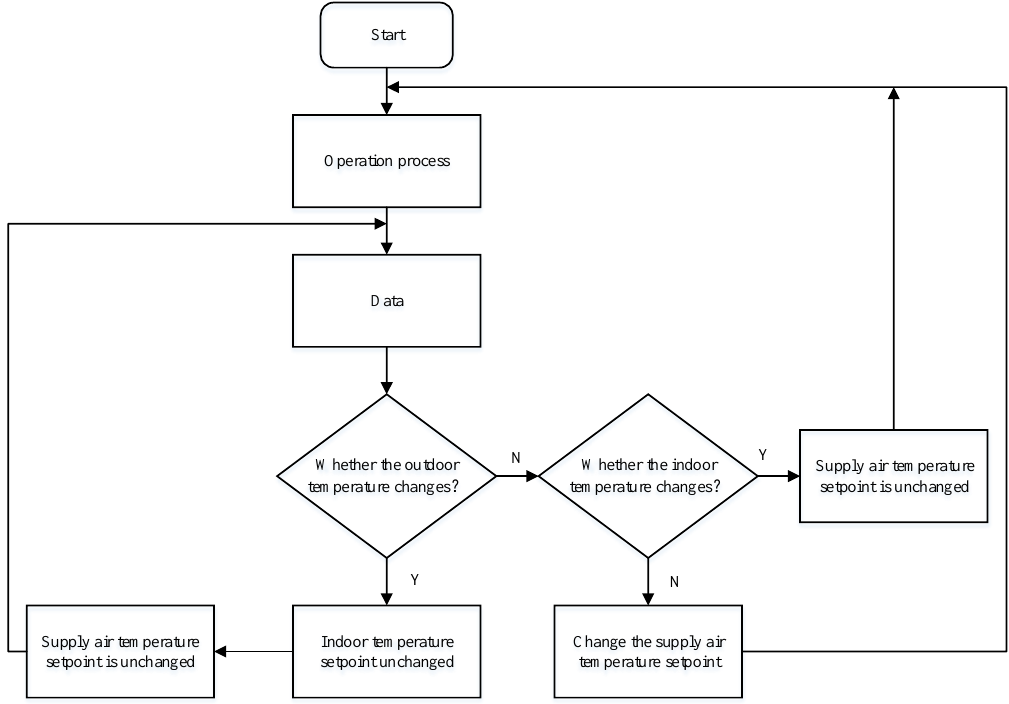
Figure 11. Climate compensation experimental process under the minimum fresh air